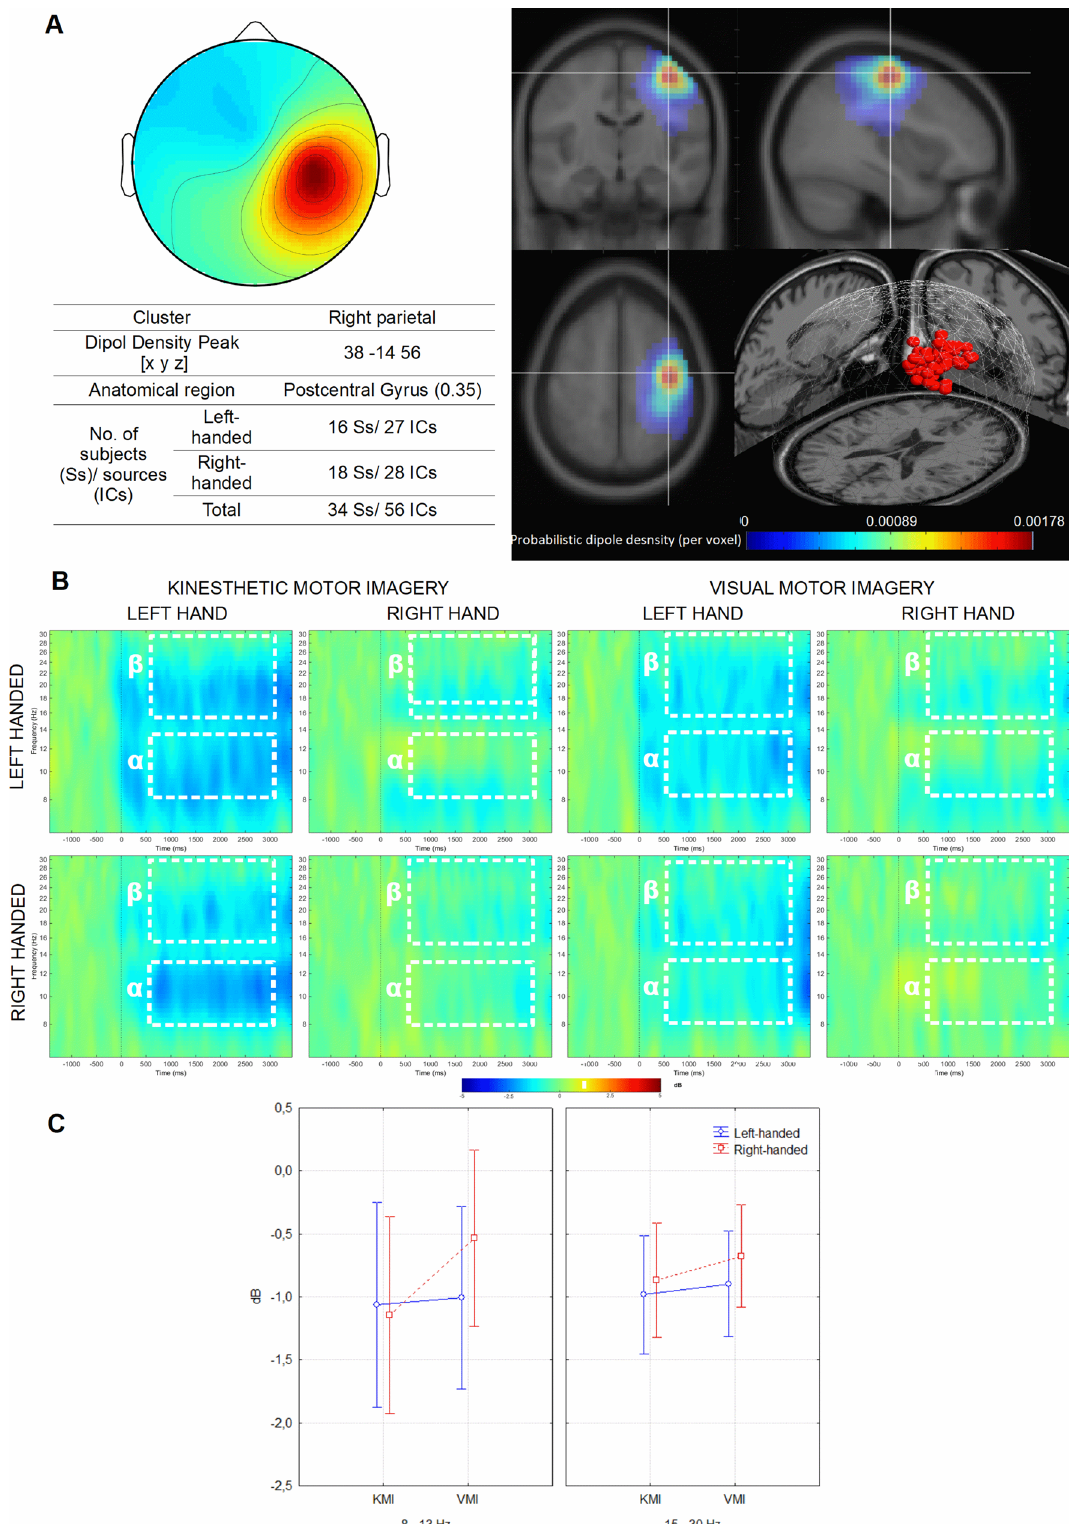
Figure 3. Right parietal cluster. ( A ) Average topography with the estimated anatomical location of the centroid (top left) and visualization of probabilistic dipoles density (top right); ( B ) mean ERSP time × frequency spectrograms from all components for both groups during left- and right hand MI in the KMI and VMI conditions. White dotted lines indicate alpha (α) and beta (β) time–frequency regions averaged for the statistical analysis. ( C ) Differences in alpha and beta ERD related to the effects of Frequency × Task × Group. The vertical bars represent standard error. Used software to create the images in this figure: MATLAB version